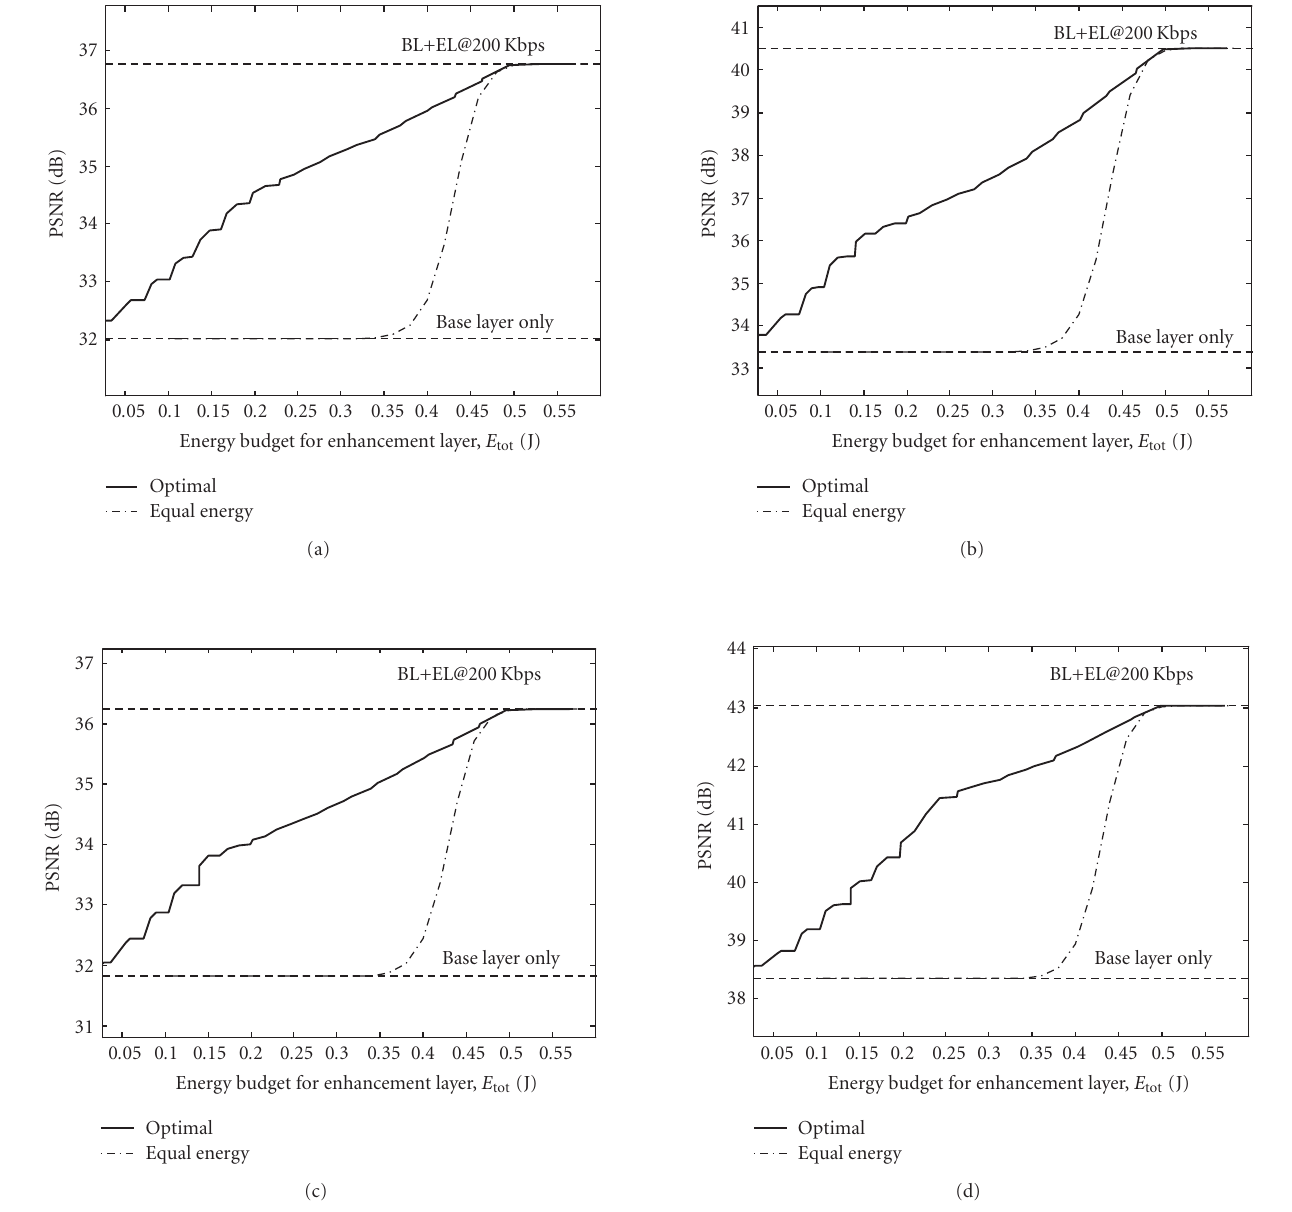
Figure 8: Performance comparison between the proposed approach and equal energy distribution (BPSK modulation, RS(160,100), B T = 200KHz). Test sequences are: (a) foreman , (b) carphone , (c) salesman , (d) akiyo